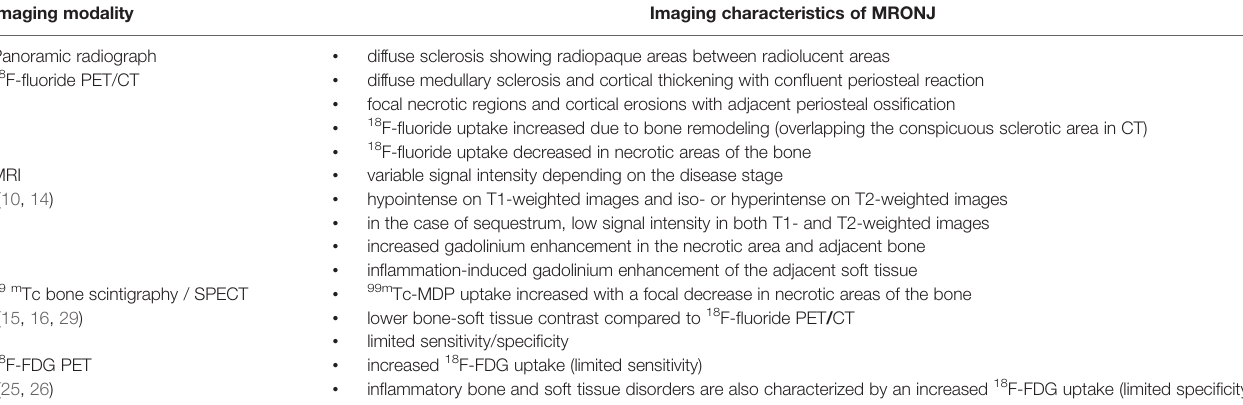
TABLE 1 | Imaging characteristics of MRONJ in 18 F- fl uoride PET/CT and panoramic radiograph compared to MRI, 99m Tc bone scintigraphy/SPECT, and 18 F-FDG PET/ CT. Imaging